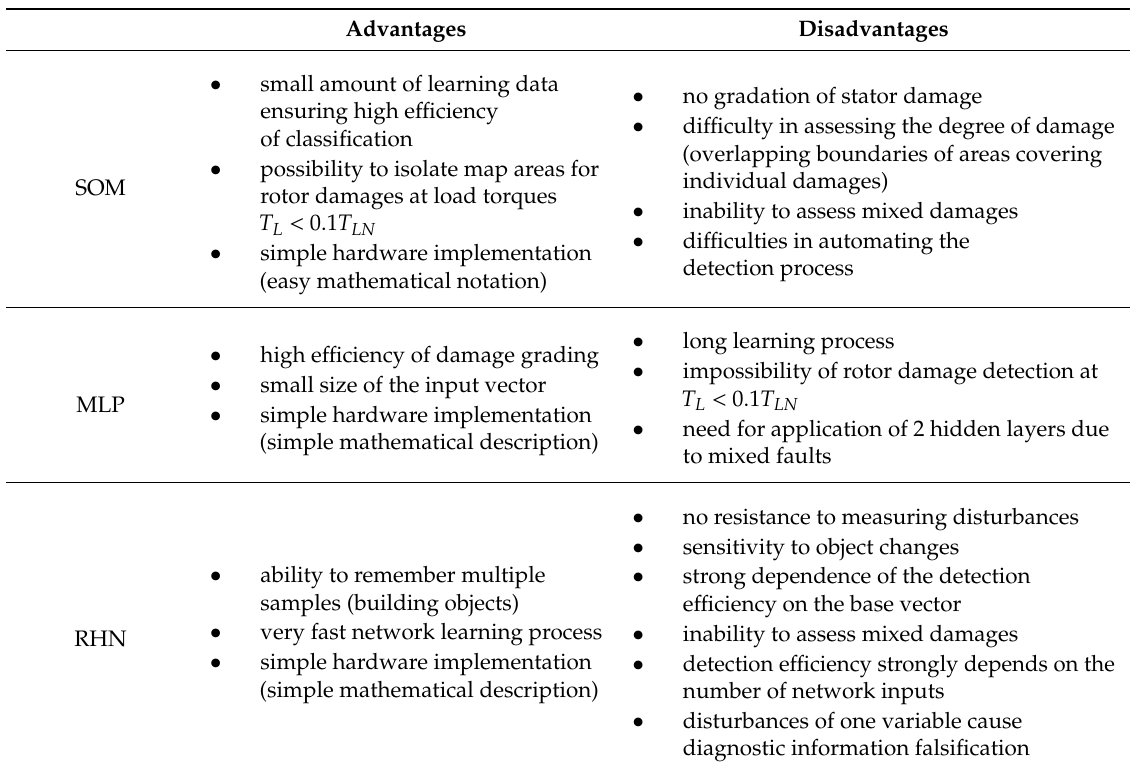
Table 4. Comparison of the winding fault detectors based on classic